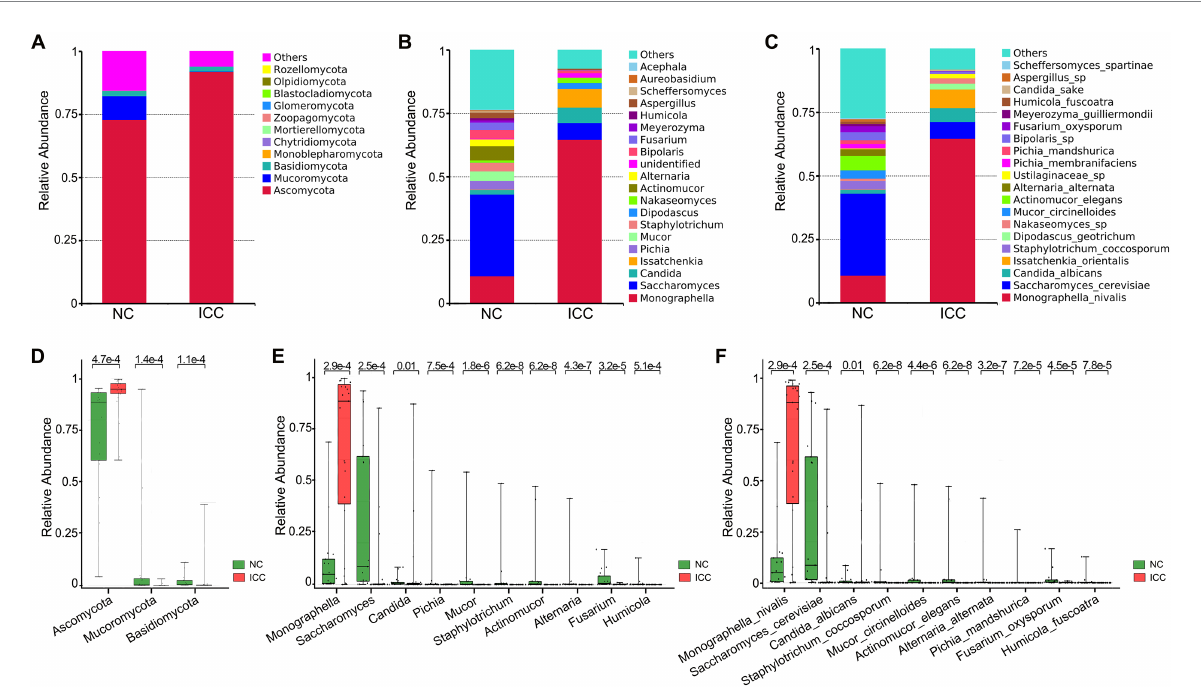
FIGURE 2 Differential analysis of fungal communities in the ICC and NC groups. Stacked bar plot of the predominant intestinal fungi at the phylum (A) , genus (B) , and species (C) levels. The three most abundant of the differential taxonomic units at the phylum level (D) between ICC patients and healthy controls. The ten most abundant of the differential taxonomic units at the genus level (E) and species level (F) between ICC patients and healthy controls. The Wilcoxon rank-sum test was used. ICC, intrahepatic cholangiocarcinoma; NC, healthy